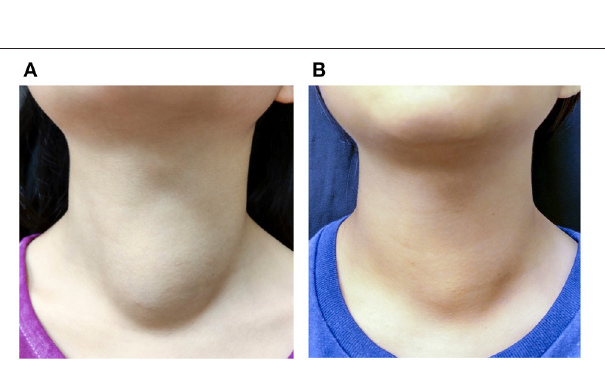
FIGURE 3 | A 10-year-old female patient with a palpable nonfunctioning thyroid mass. (A) Before RF ablation, the cosmetic score was 3 and symptom score was 0. The initial nodule volume was 23.53 mL. (B) At 6 months after the ablation, the cosmetic score remained at 3 and symptom score was 0. The nodule volume was 15.99